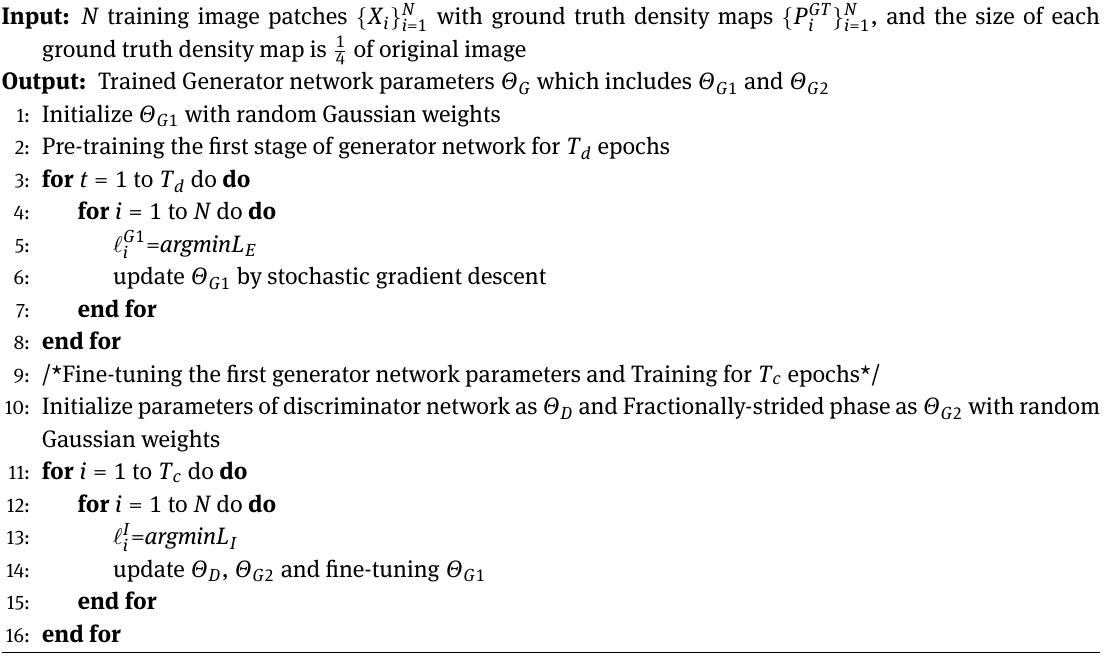
Algorithm 1 The training process of estimating density map for our